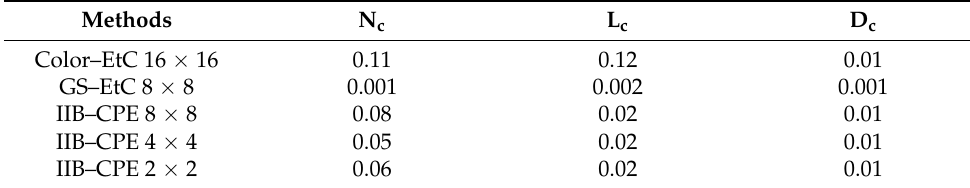
Table 2. Robustness of the perceptual encryption methods against jigsaw puzzle solver attacks. ( N c : neighbor comparison, L c : largest component comparison, D c : direct